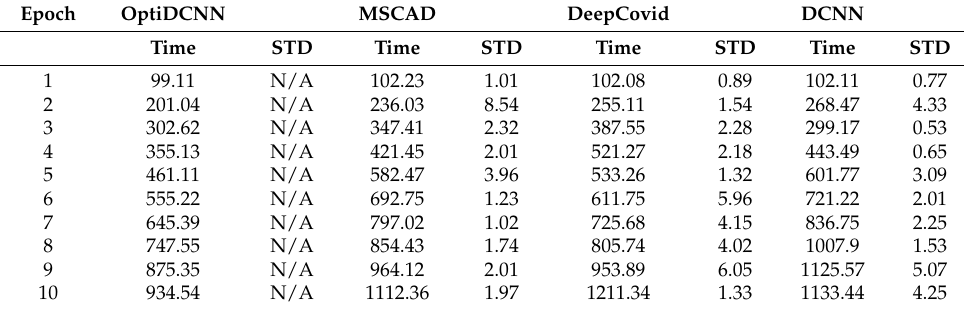
Table 6. Computation time (in seconds) and STD for benchmark